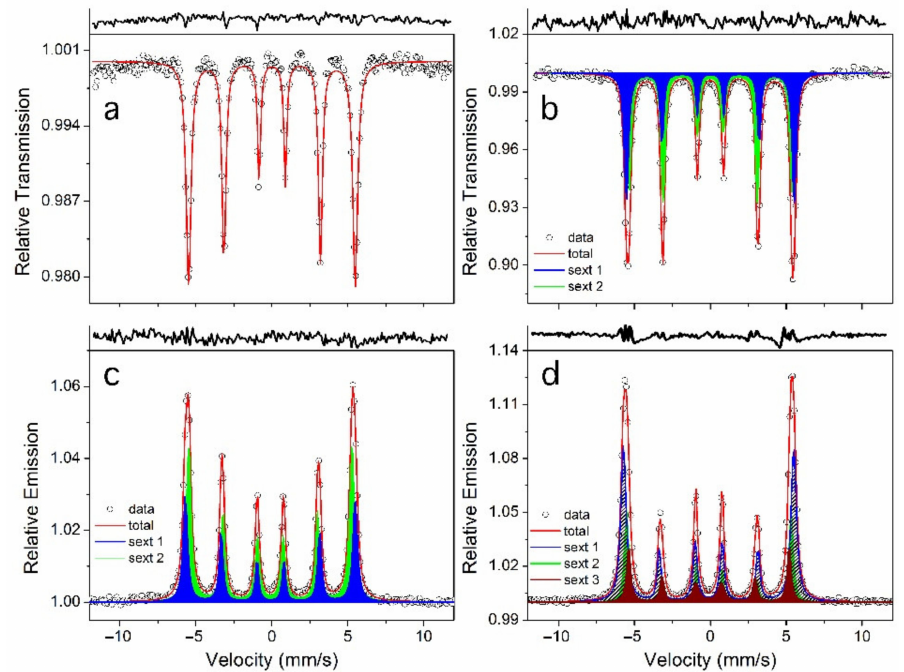
Figure 11. Mössbauer spectra of the interiors of Find 1 iron meteorite ( a , c ) and Campo del Cielo meteorite ( b , d ) measured at RT in transmission ( a , b ) and backscattering ( c , d )